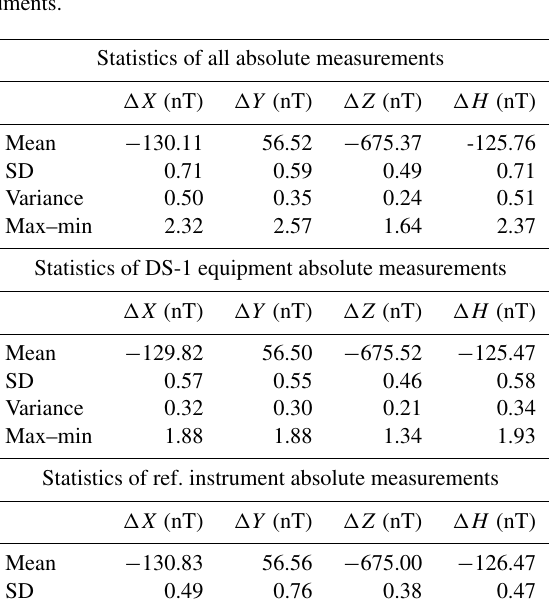
Table 2. Statistics of baseline corrections at all and individual in-